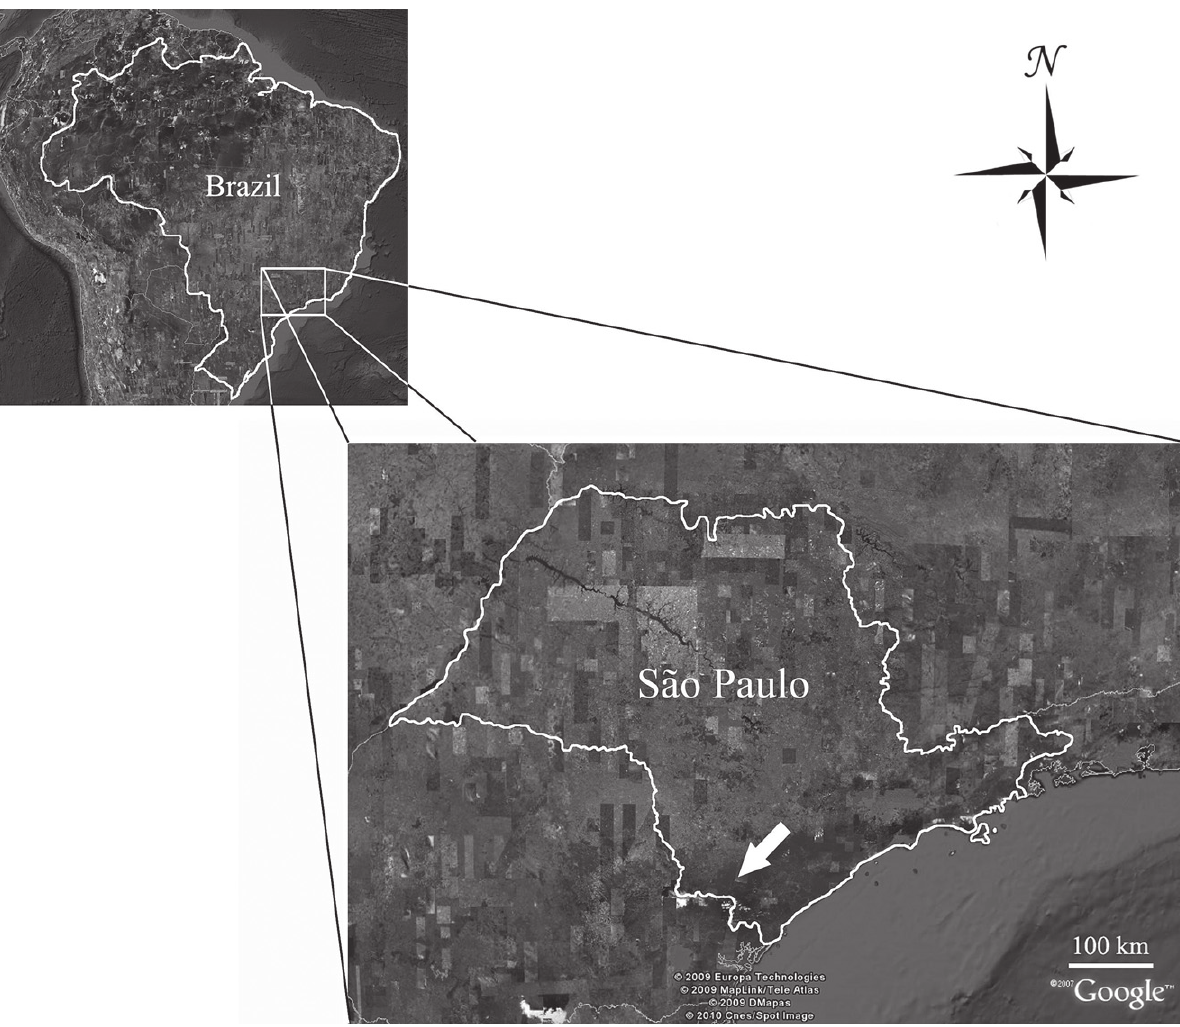
Fig. 1 - Location of Parque Estadual Intervales (PEI), Iporanga, São Paulo State, Brazil (modi fi ed from Google Earth (2010), Digital Globe